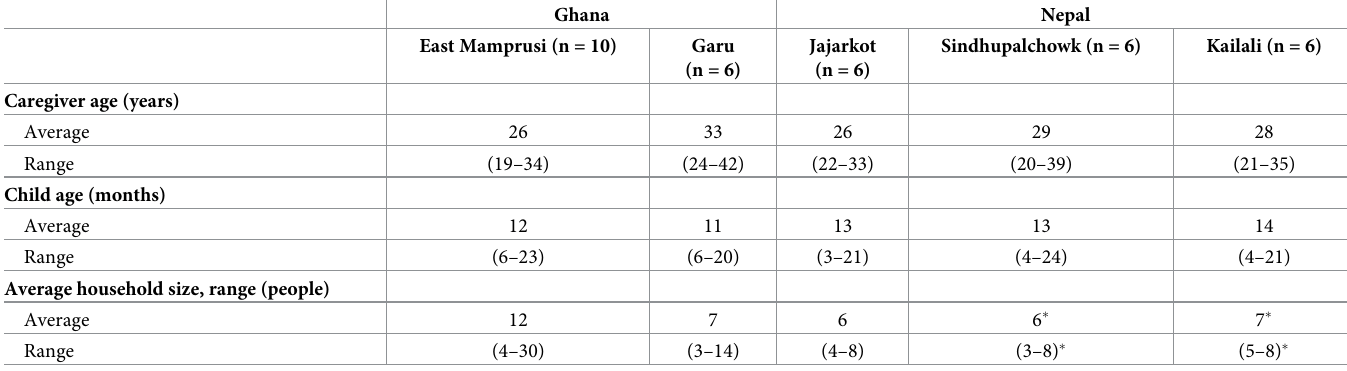
Table 3. Characteristics of caregivers interviewed and the child they brought to